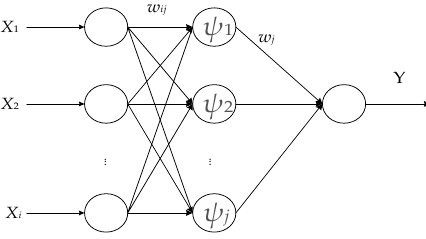
Figure 1. Topology of wavelet neural network.